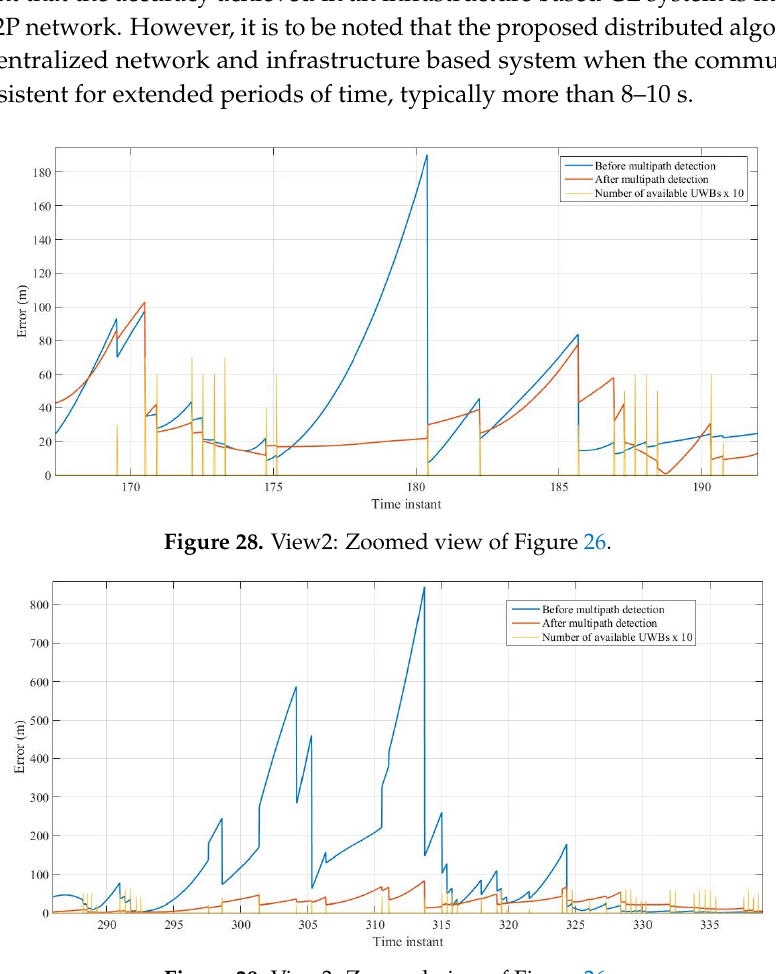
Figure 29. View3: Zoomed view of Figure